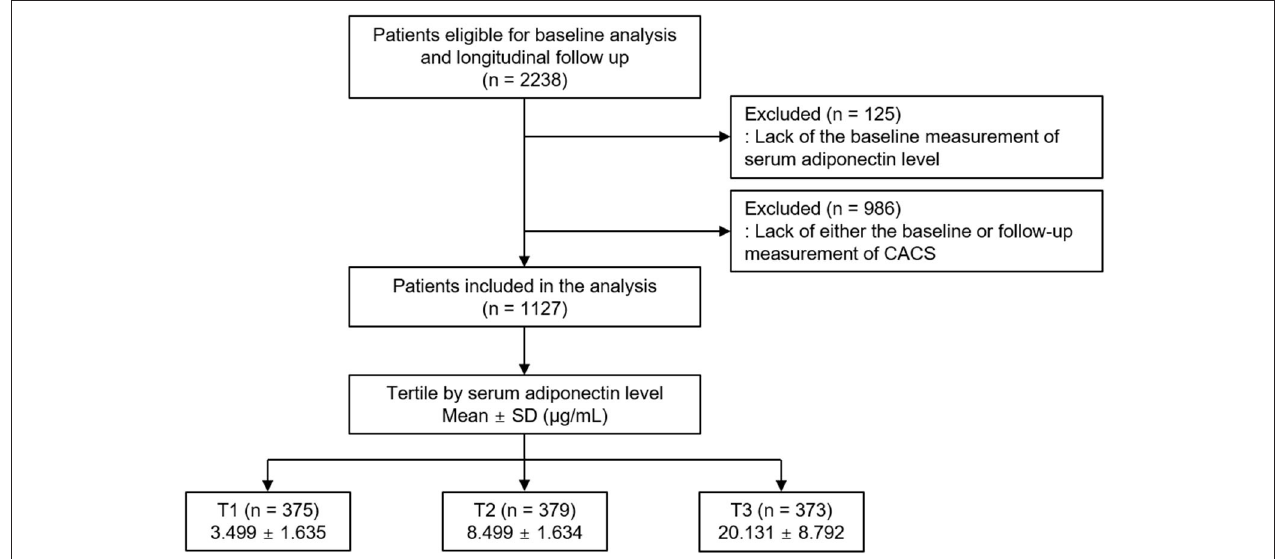
FIGURE 1 | Flow diagram of the study participants. CACS, coronary artery calcium score; SD, standard deviation; CACS, coronary artery calcium score; T1, 1st tertile; T2, 2nd tertile; T3, 3rd tertile.